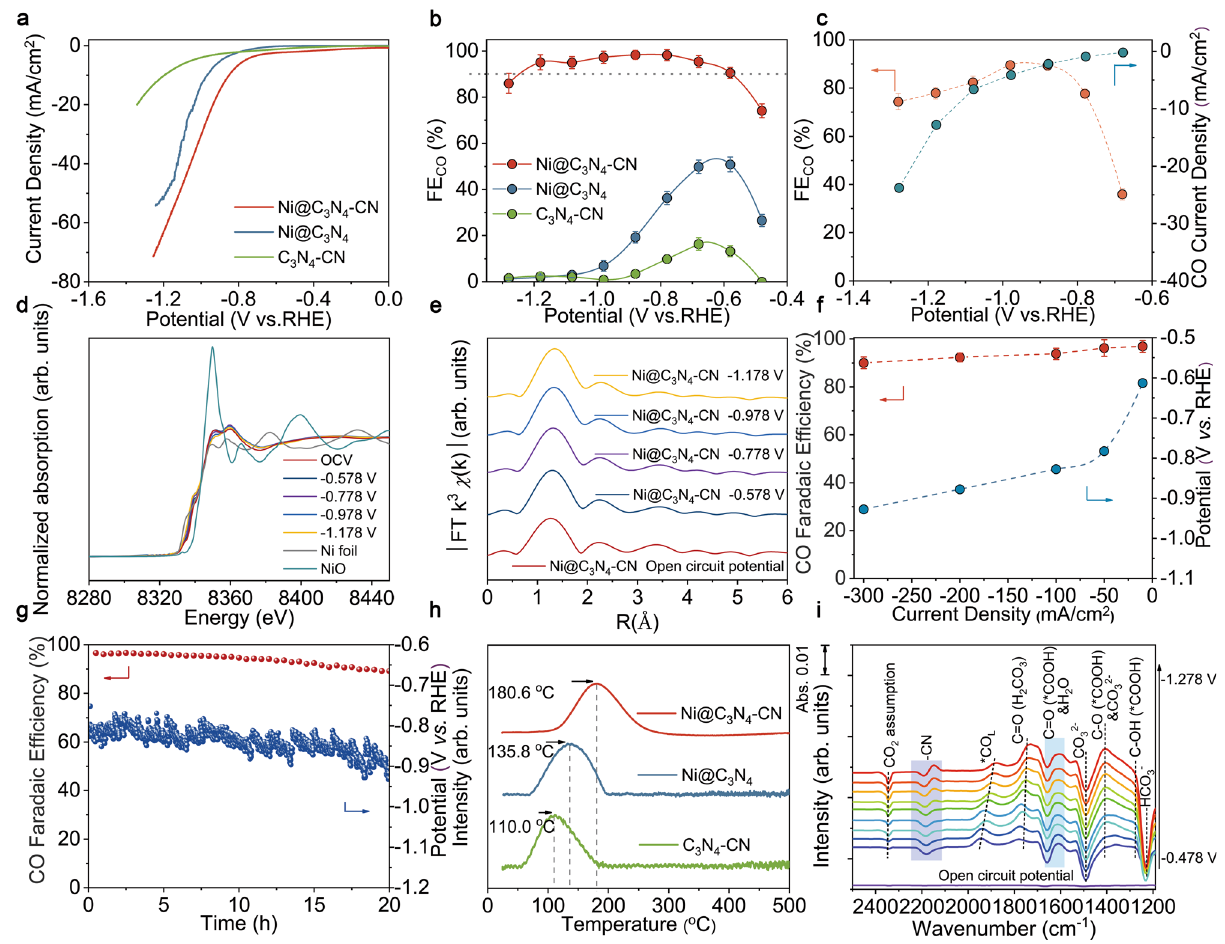
Fig.4|ElectrochemicalCO 2 RRperformances.a LSVcurvesatscanrateof10mV/ s in H-cell with pure CO 2 saturated 0.5M KHCO 3 solution. b FE CO at different potentials in H-cell under pure CO 2 . c FE CO and J CO of Ni@C 3 N 4 -CN at different potentials under 30% CO 2 concentration. d In situ XANES spectra of Ni@C 3 N 4 -CN measured at different potentials. e In situ k 3 weighted Fourier transform EXAFS spectra of Ni@C 3 N 4 -CN. f The potentials and FE CO at different current densities